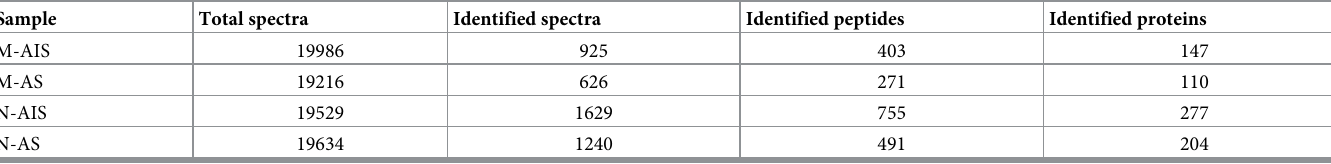
Table 2. The MS information of the four samples extracted from P . viridis shell. M-AIS, the acid-insoluble sample from myostracum layer. M-AS, the acid-soluble sample from myostracum layer. N-AIS, the acid-insoluble sample from nacre layer. N-AS, the acid-soluble sample from nacre layer.